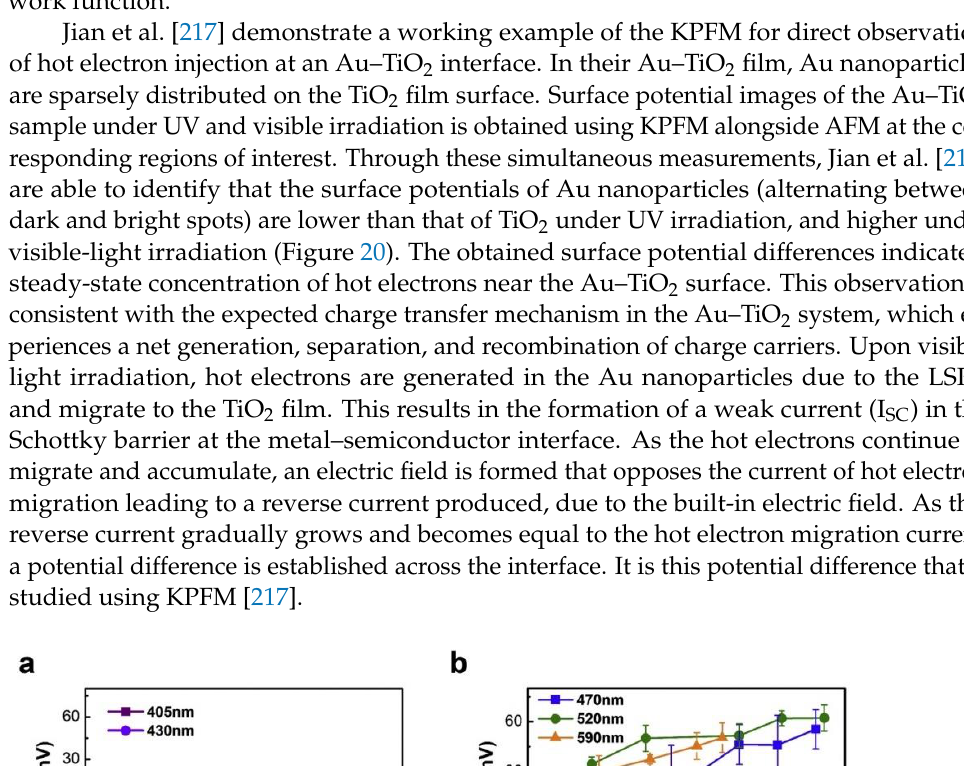
Figure 20. Using KPFM, Jian et al. [217] are able to study the modulation of the surface potential as a function of the light of power. ( a – c ) It is observed that with increasing light power toward the LSPR wavelength, more electrons are excited and flow to the Au nanoparticles resulting in a de- crease in the surface potential of the Au nanoparticle. This switches upon the start of LSPR absorp- tion resulting in a potential rise from −36 mV to 30 mV and gradual saturation at longer wave- lengths. ( d ) Narrow band-pass filters of visible light for six central wavelengths: 405 nm, 430 nm, 470 nm, 520 nm, 590 nm, and 780 nm corresponding to characteristics of the absorption spectrum of Au nanoparticles (the dip, the low absorption peak, LSPR absorption, LSPR peak, end of LSPR absorption, and the long wavelength side). Reprinted with permission from Ref. [217] Copyright Elsevier (2019). Among others, Jian et al. [217] also observe that the saturated surface potential fol- lows the absorption spectrum of the Au nanoparticles. In this manner, KPFM is a versatile tool that can be used to observe charge transfer dynamics and phenomena at plasmonic interfaces. Lee et al. [218] demonstrate a similar run of experiments using the KPFM probe to directly observe plasmon-induced interfacial charge separation in metal–semiconduc- tor hybrid nanostructures, where Au nanoparticles are attached to ZnO nanowires. They further extend this work to be successfully applied in characterizing plasmon–exciton or plexcitonic coupling between p-type poly(pyrrole) (PPy) nanowires and Ag nanoparticles. Apart from providing a means to observing the charge-transfer dynamics at plasmonic interfaces, Li et al. [219] have shown that KPFM can also be utilized to provide direct ob- servations of the LSPR enhancements in plasmonic systems. Li et al. [219] use KPFM to observe the LSPR induced surface potential reduction in the vicinity of Ag nanoparticles on a GaN epilayer. Under UV irradiation, LSPR induced local field enhancements force photogenerated electrons to drift close to the Ag nanoparticles thus leading to a reduction of the surface potential around the nanoparticles. Similarly, KPFM mapping of the surface potential of Au nanoparticles on nonpolar ZnO and TiO 2 nanotubes under UV irradiation have demonstrated greater understanding of the origins of the LSPR field enhancement and plasmonic interfacial charge dynamics [220,221]. These experiments support the growing support towards the use of KPFM for diverse experiments in understanding charge transfer dynamics, and LSPR field enhancement studies in plasmon enhanced pho- tocatalytic and optoelectronic devices.